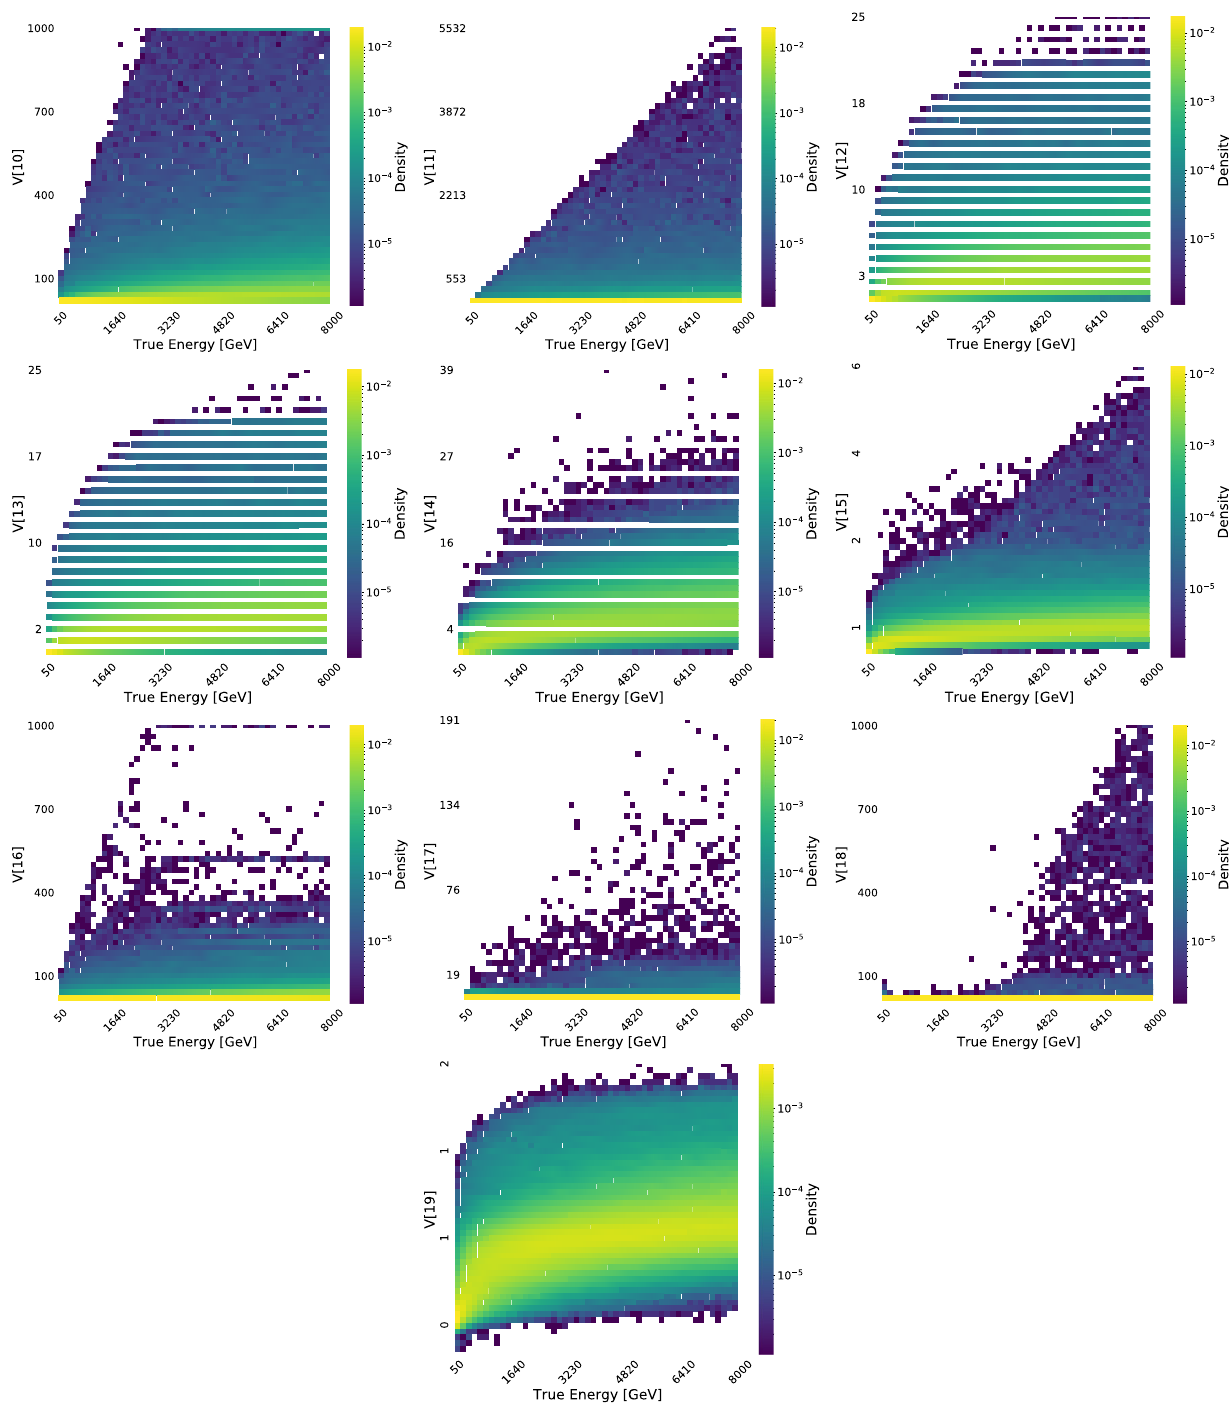
Fig. 19 2D histograms showing the dependence of features V[10] to V[19] (on the y axes) on true muon energy (on the x axes). Features are defined in Sect.